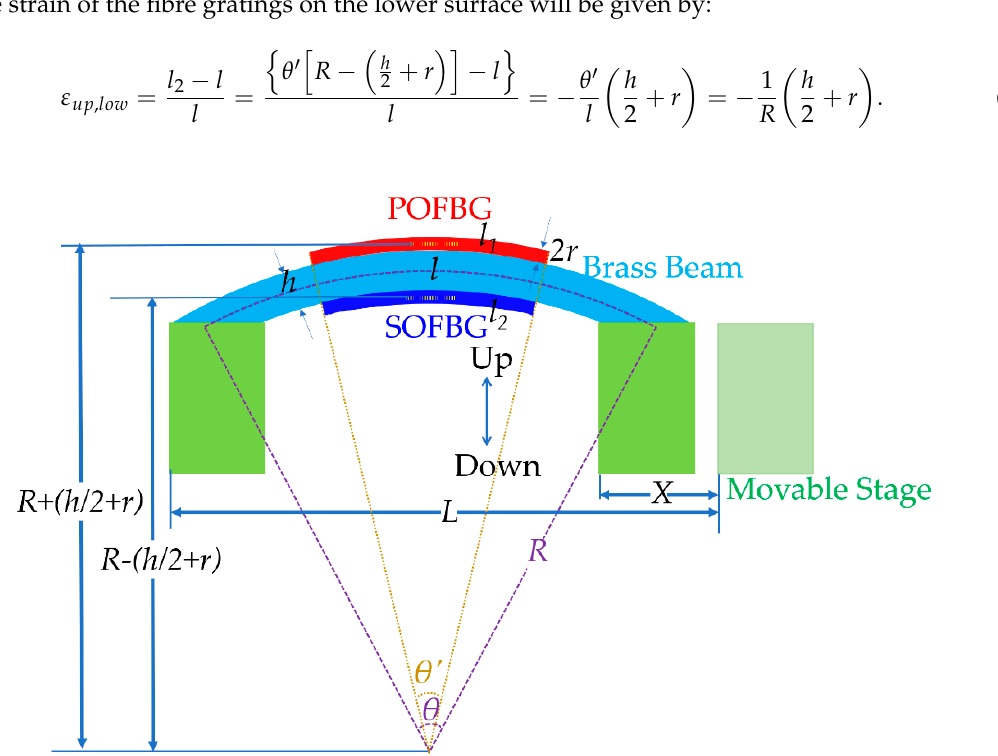
Figure 1. A typical experimental scheme for the vector bend sensing of brass beam with POFBG and SOFBG.